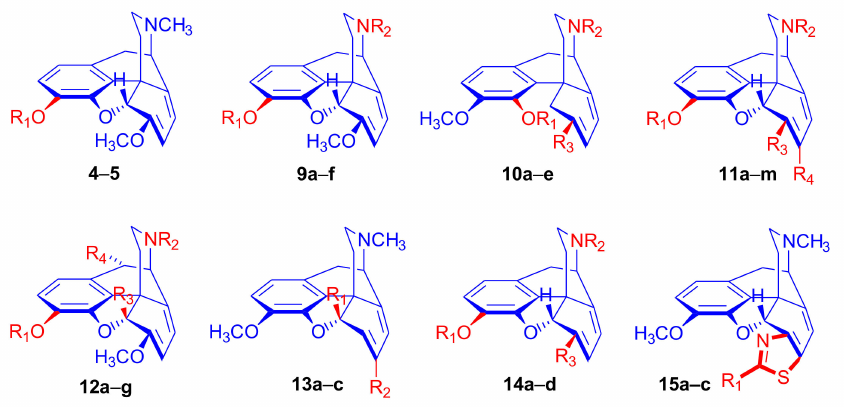
Figure 2. Structures of selected morphinan-6,8-dienes.